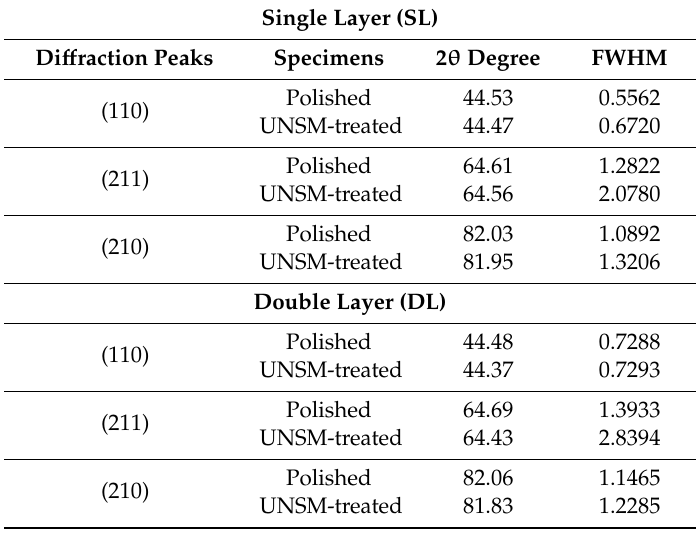
Figure 8. XRD patterns of the polished and UNSM-treated single and double layers ( a ). Primary peak ( b ), secondary peak I ( c ) and secondary peak II ( d ). Table 6. 2 θ position and full width at half maximum (FWHM) value information obtained from XRD patterns of the polished and UNSM-treated single and double layers.